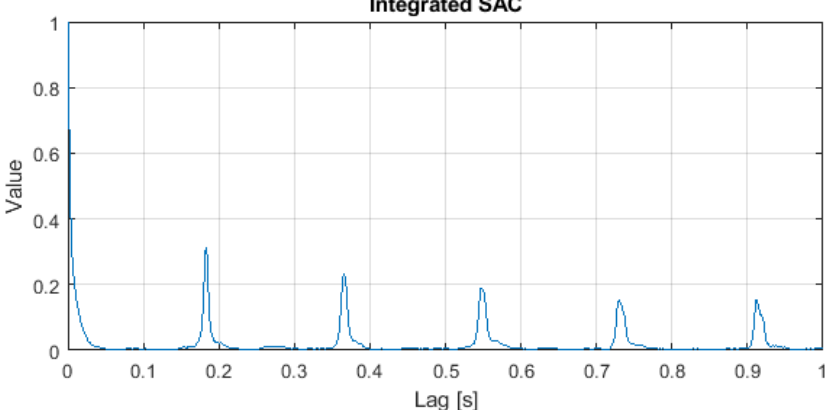
Figure 13. Integrated spectral autocorrelation map.